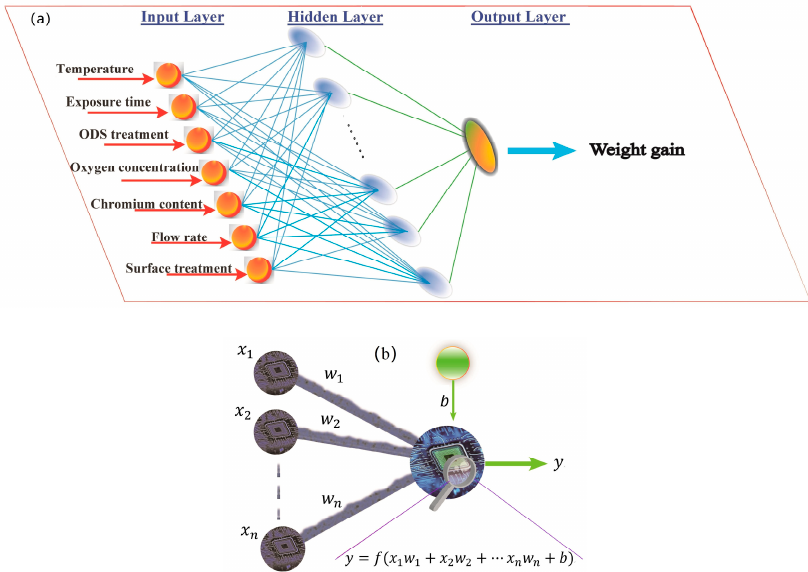
Figure 1. ( a ) A three-layer network used for prediction on the weight gain and ( b ) the processing information schematic of a single artificial neuron. information schematic of a single artificial